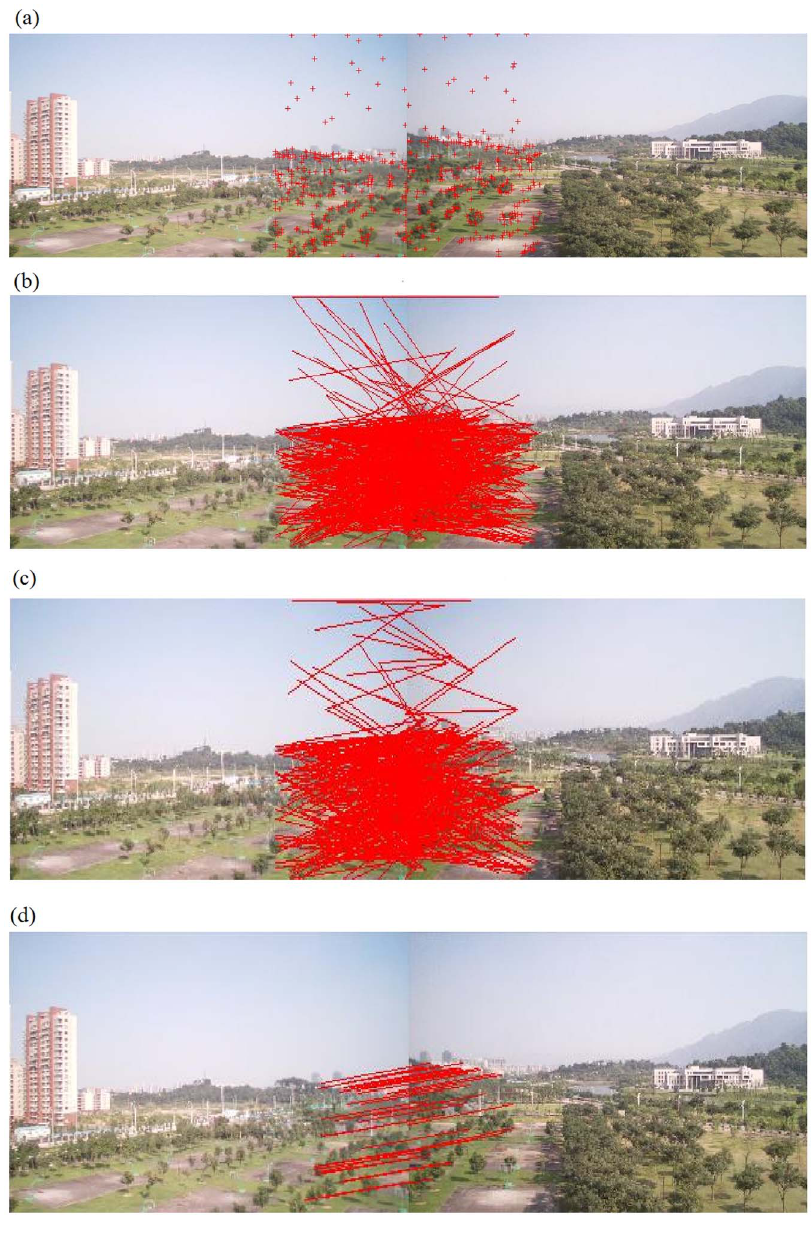
Figure 4. The first experiment on the corner matching efficiency: (a) Selected corners (using our algorithm) from two original images; (b) Corner matching by traditional RANSAC algorithm (NCC rough match); (c) Initial set of matching-corner pairs in our algorithm; (d) Final set of matching-corner pairs in our algorithm.